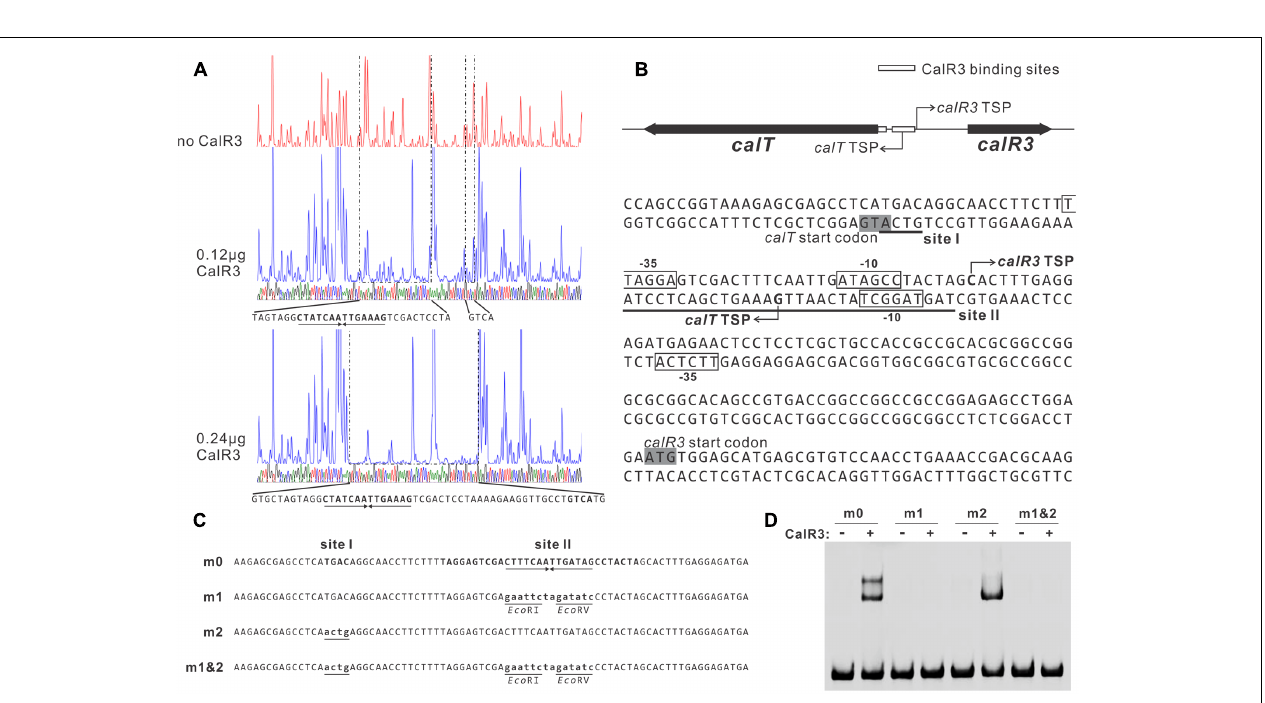
FIGURE 5 | Determination of the binding sites of CalR3 protein. (A) DNase I footprinting assay of CalR3 on the T-R3L region. The fluorograms correspond to the control reaction without CalR3 protein and to the protection patterns with increasing CalR3 protein (0.12 and 0.24 µ g). (B) Nucleotide sequences of the T-R3L promoter region and CalR3-binding site. Solid line, CalR3-binding site; shaded areas, translational start codons; bent arrow, TSPs; boxes, putative –10 and –35 regions. (C) Mutations introduced into the CalR3 binding sites I and II regions. Each probe was 80 bp. Probe m0 was WT DNA containing a 14 bp palindromic sequence in site II. Base substitutions were introduced into probe m0 to produce mutated probes m1, m2, and m1&2, respectively. Altered nucleotides are underlined. (D) EMSAs with WT DNA probe and mutated probes. Each reaction mixture contained 1.5 µ M probe and 0.8 µ M of purified His 6 -CalR3 protein.